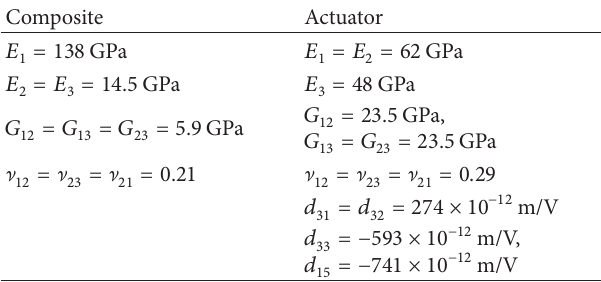
Table 1: Material properties of composite lamina and PZT-5H